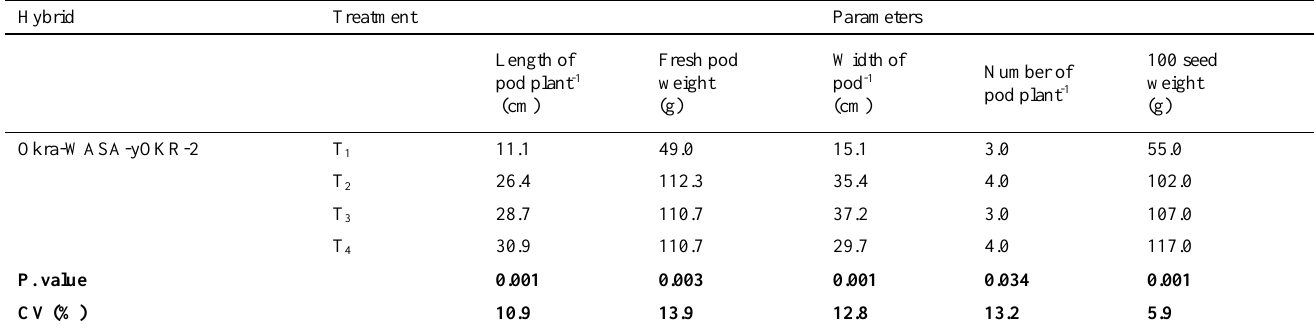
Table 3 . Mean values of yield components parameters as affected by fertilizer